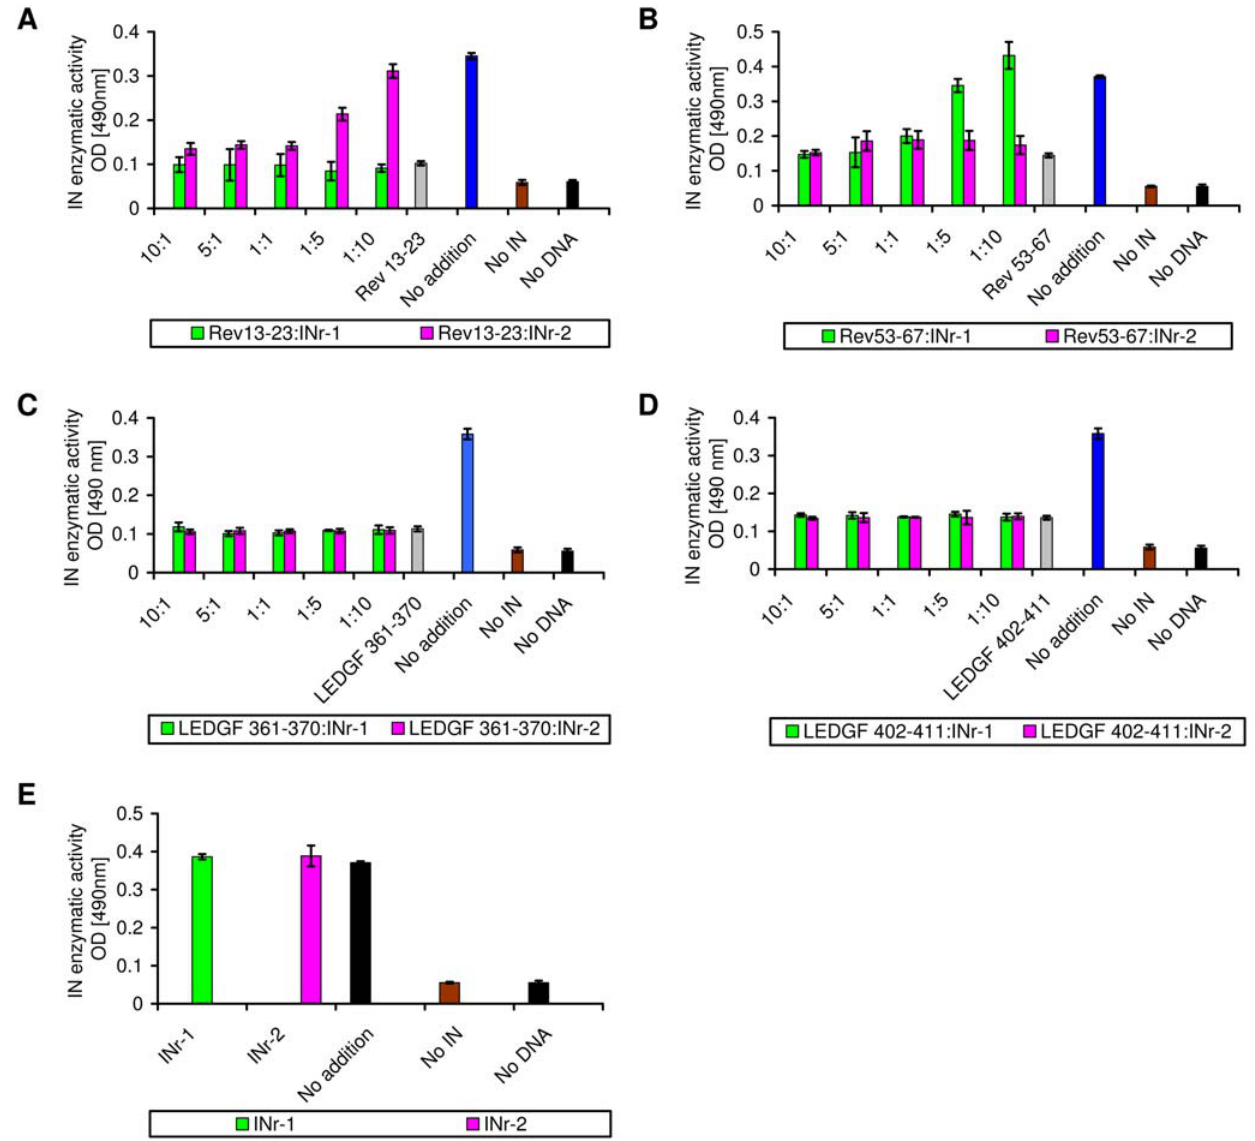
Figure 3. Inhibition of IN activity by Rev- and LEDGF-derived peptides: specific abrogation by the INr peptides. IN (390 nM) was incubated with 50 m M of the Rev-derived peptides (1:300 IN:Rev-derived peptide) [22] (Rev13–23 (A) and Rev 53–67 (B) ) or LEDGF-derived peptides [36] (LEDGF 361–370 (C) ) and LEDGF 402–411 (D) ) and then the INr peptides were added at different molar ratios ranging from 10:1 to 1:10 (Rev or LEDGF peptide:INr peptide). (E) IN (390 nM) was incubated with the INr peptides (50 m